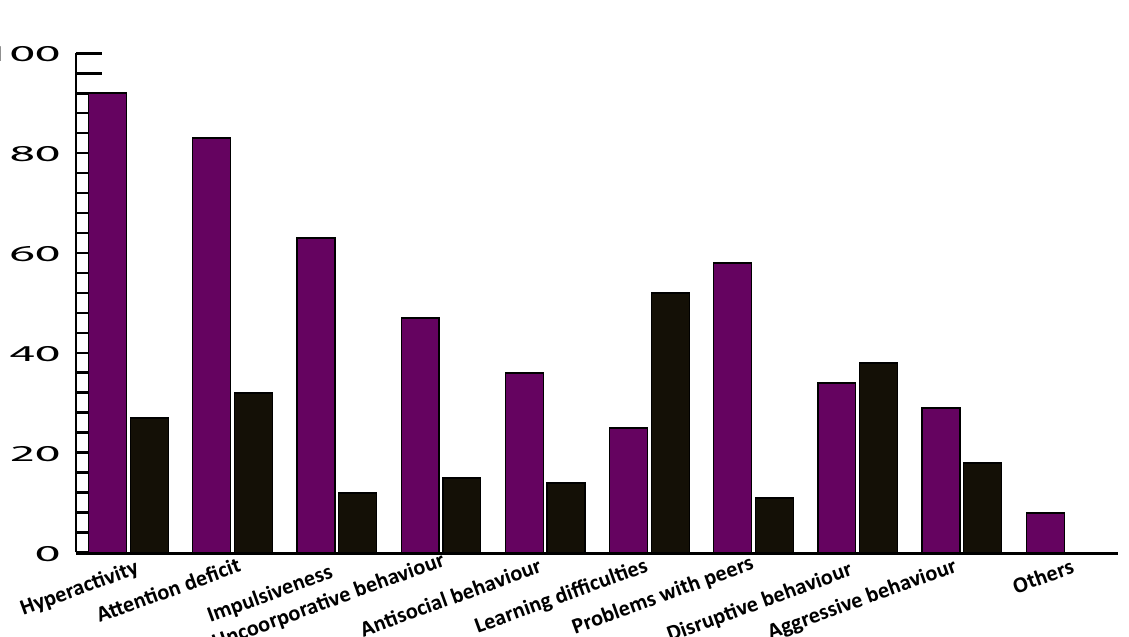
Fig. 1 Frequency of individual symptoms at entry into programme and at 6 months following